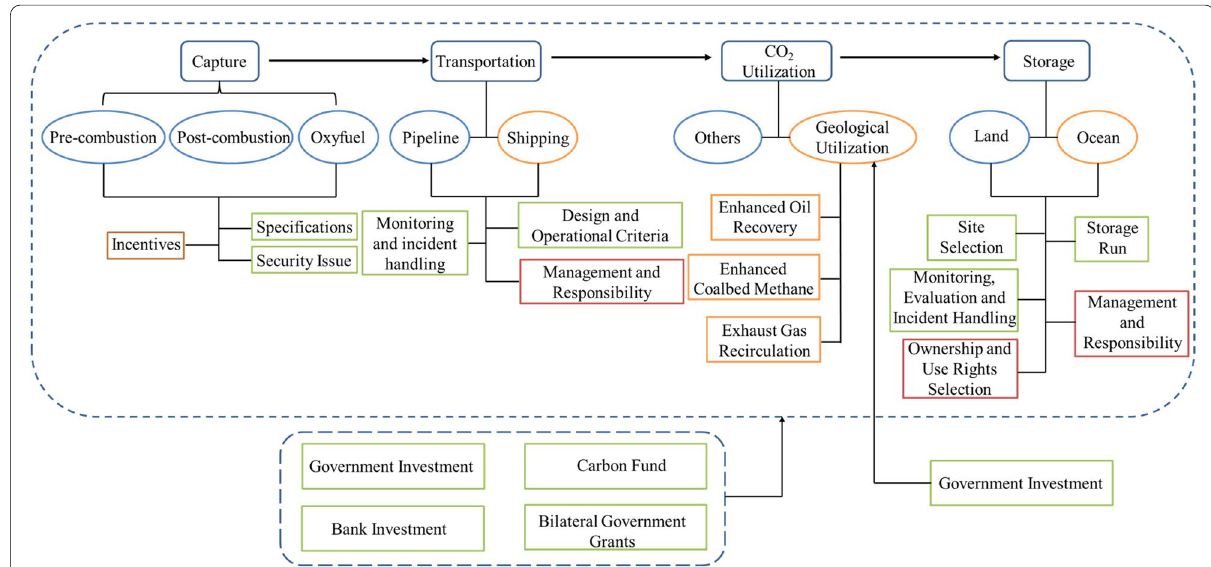
Fig. 7 Framework diagram of CCS policy and regulation requirements (green represents existing relevant standards or regulations, orange represents lack of relevant policies and regulations, and red represents the focus of debate among